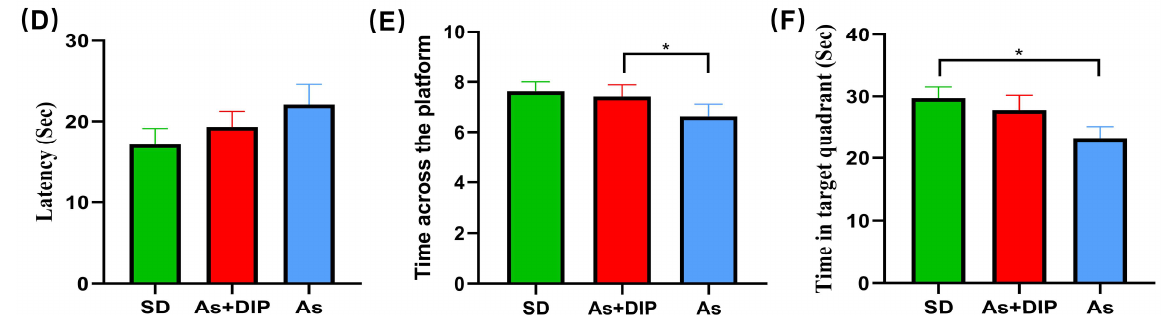
Figure 1. Schematics for study design and behavioral tests. ( A ) Schematic diagram of the whole experiment. ( B ) The escaping latencies of rats in the 4-day trials. ( C ) The representative swimming track lines of rats in the 4-day trials. ( D ) The escaping latencies of rats. ( E ) The times of rats crossing over the hidden location of the platform. ( F ) The time of mice spent in the target quadrants. * p < 0.05, n = 20. ( D – F ) In the probe trail at 24 h after the 4-day successive training.